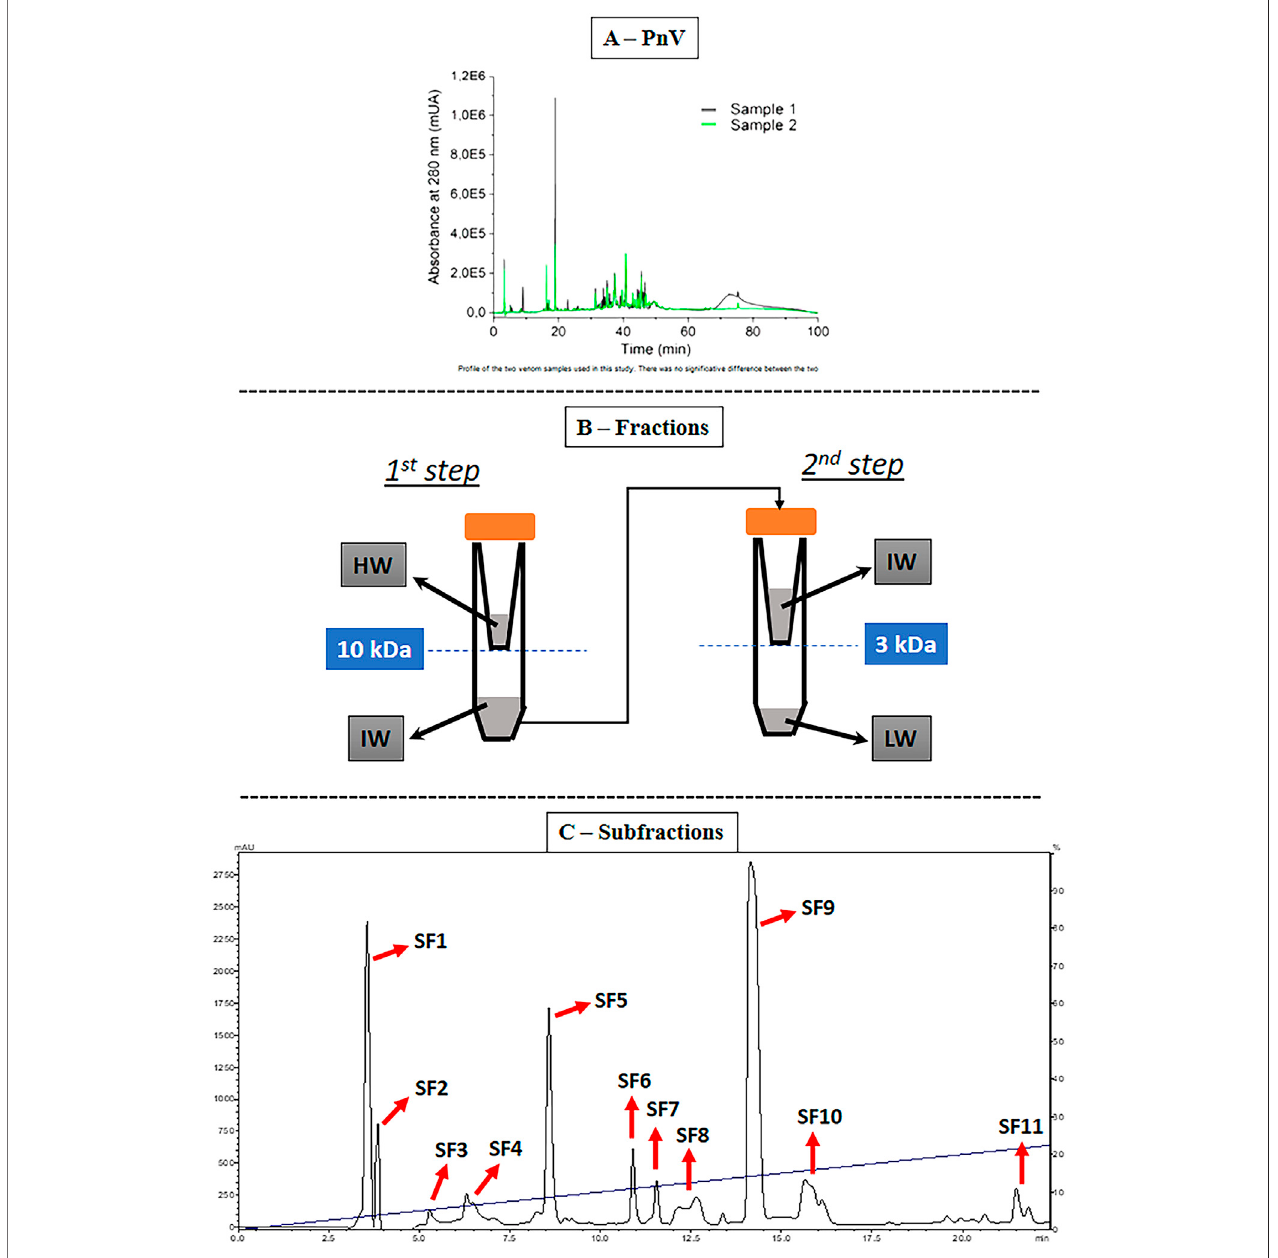
FIGURE 1 | Venom samples and puri fi cation. (A) Venom pro fi le by high performance liquid chromatography (HPLC). There was no signi fi cant difference between the two PnV samples used in this study. (B) Stages of the fi rst PnV fractioning. This procedure consists in separating the fractions by molecular mass using molecular fi lters with nominal separation at 10 and 3 kDa. LW = low weight, less than 3 kDa (F1); IW = intermediate weight, molecules between 3 and 10 kDa (F2); HW = high weight, above 10 kDa (F3). (C) Fractions F1 + F2 together were repuri fi ed, obtaining 11 subfractions (SF1 –